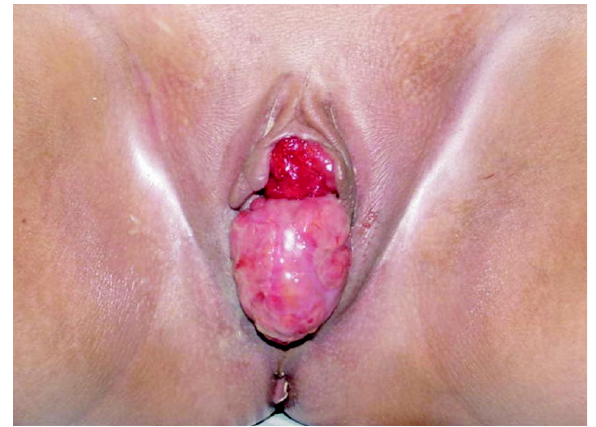
Figure 1 – Tumor exteriorization through the